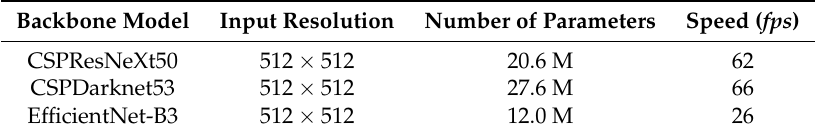
Table 2. Comparisons of three backbone models in terms of number of parameters and speed ( fps ) using an RTX 2070